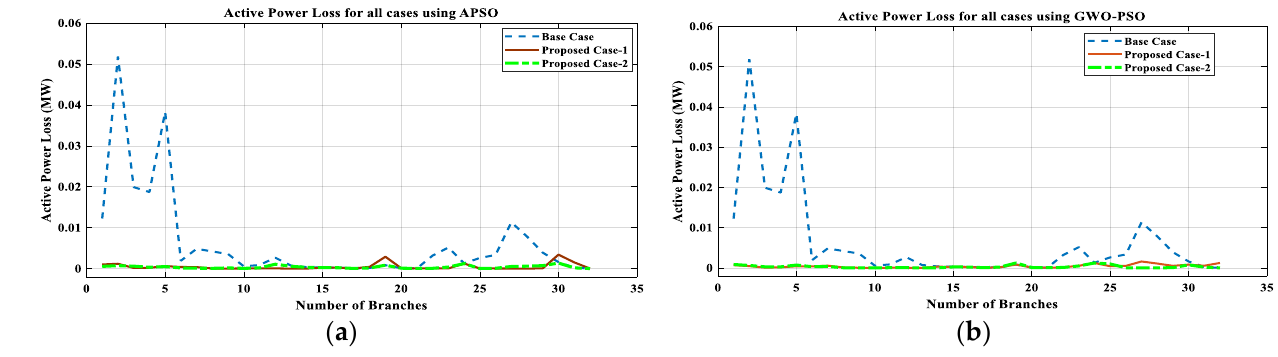
Figure 11. Real power loss for all cases of 33-bus RDN; ( a ) APSO, ( b ) GWO-PSO.